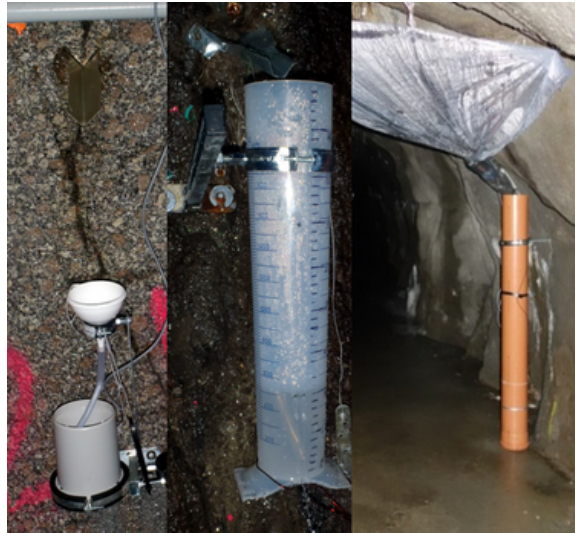
Fig. 5. Methods of the water discharge measurement. On the left: tipping bucket (observation point V2). In the middle: danaide (V7). On the right: measuring cylinder